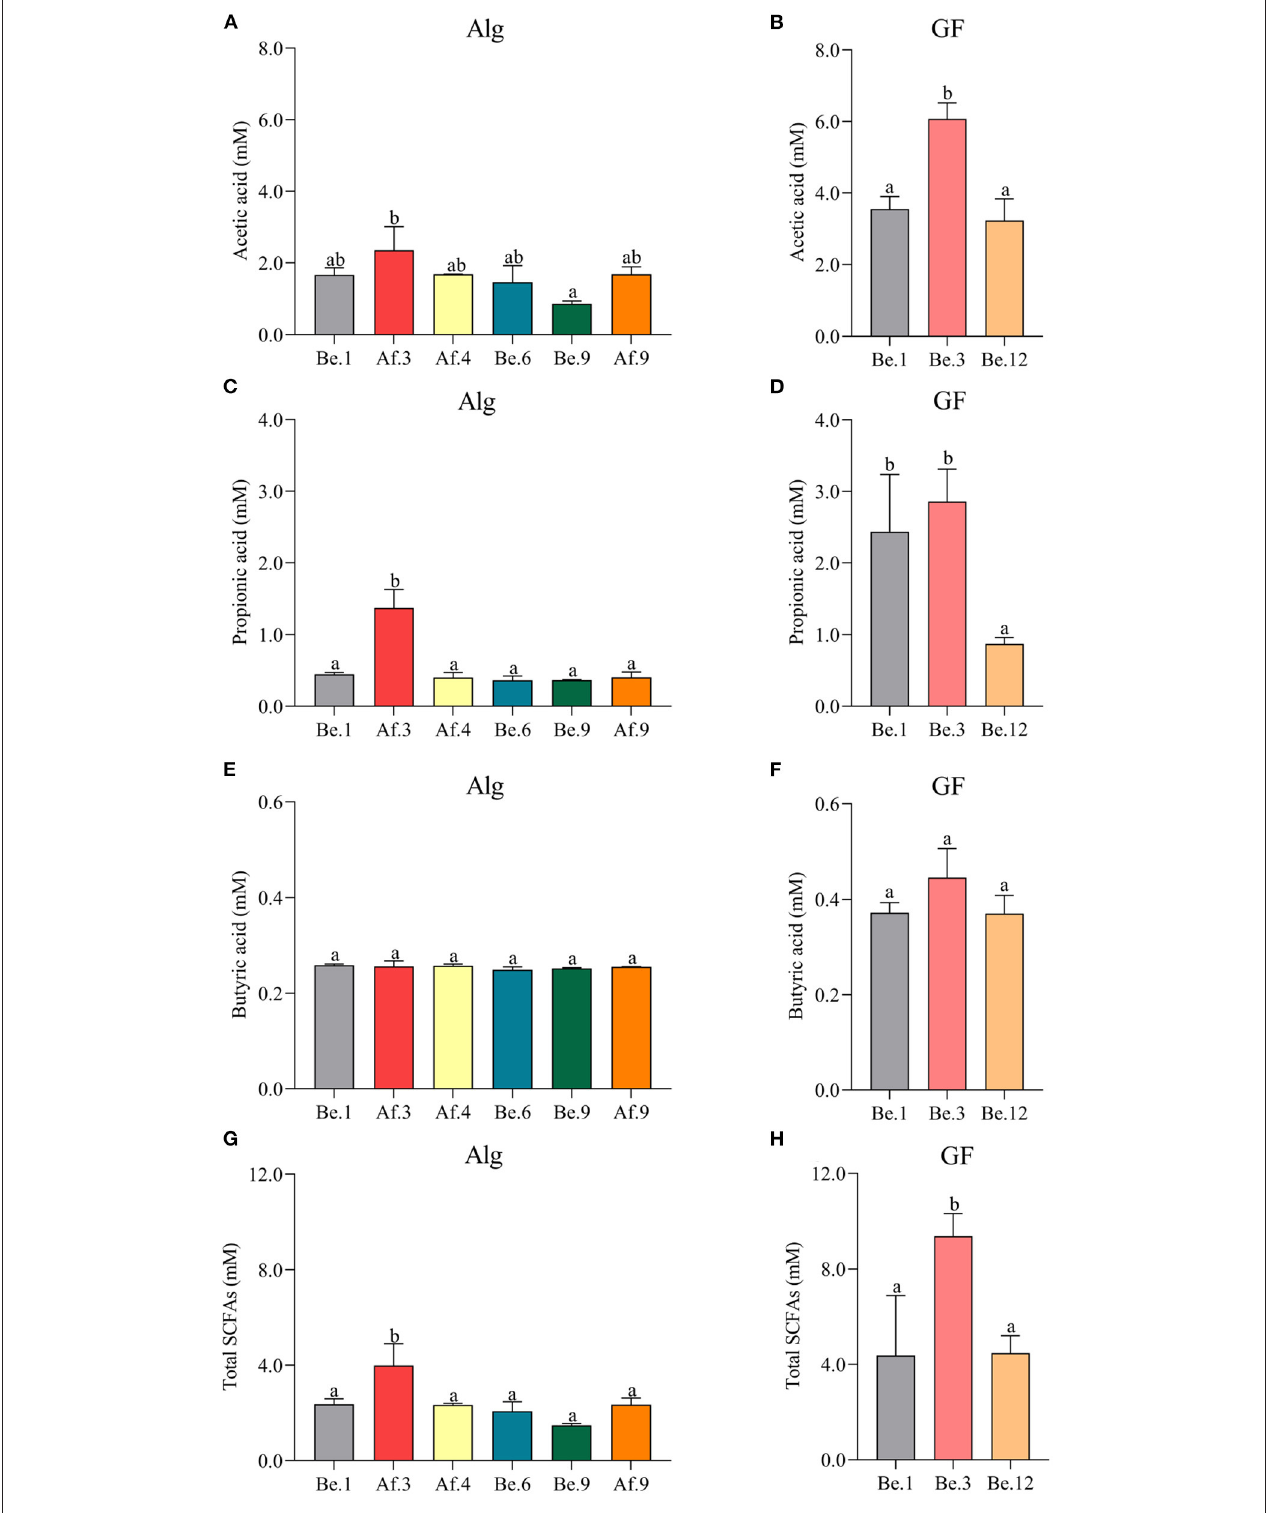
FIGURE 4 | The productions of acetic acid (A,B) , propionic acid (C,D) , butyric acid (E,F) , and total short-chain fatty acids (SCFAs) (G,H) after the fermentation of Alg and GF for 48h. Graph bars marked with different letters on top represent statistically significant results ( p < 0.05) based on one-way analysis of variance (ANOVA) followed by the Tukey’s Honestly Significant Difference (HSD) test, whereas bars labeled with the same letter correspond to results that show no statistically significant differences.